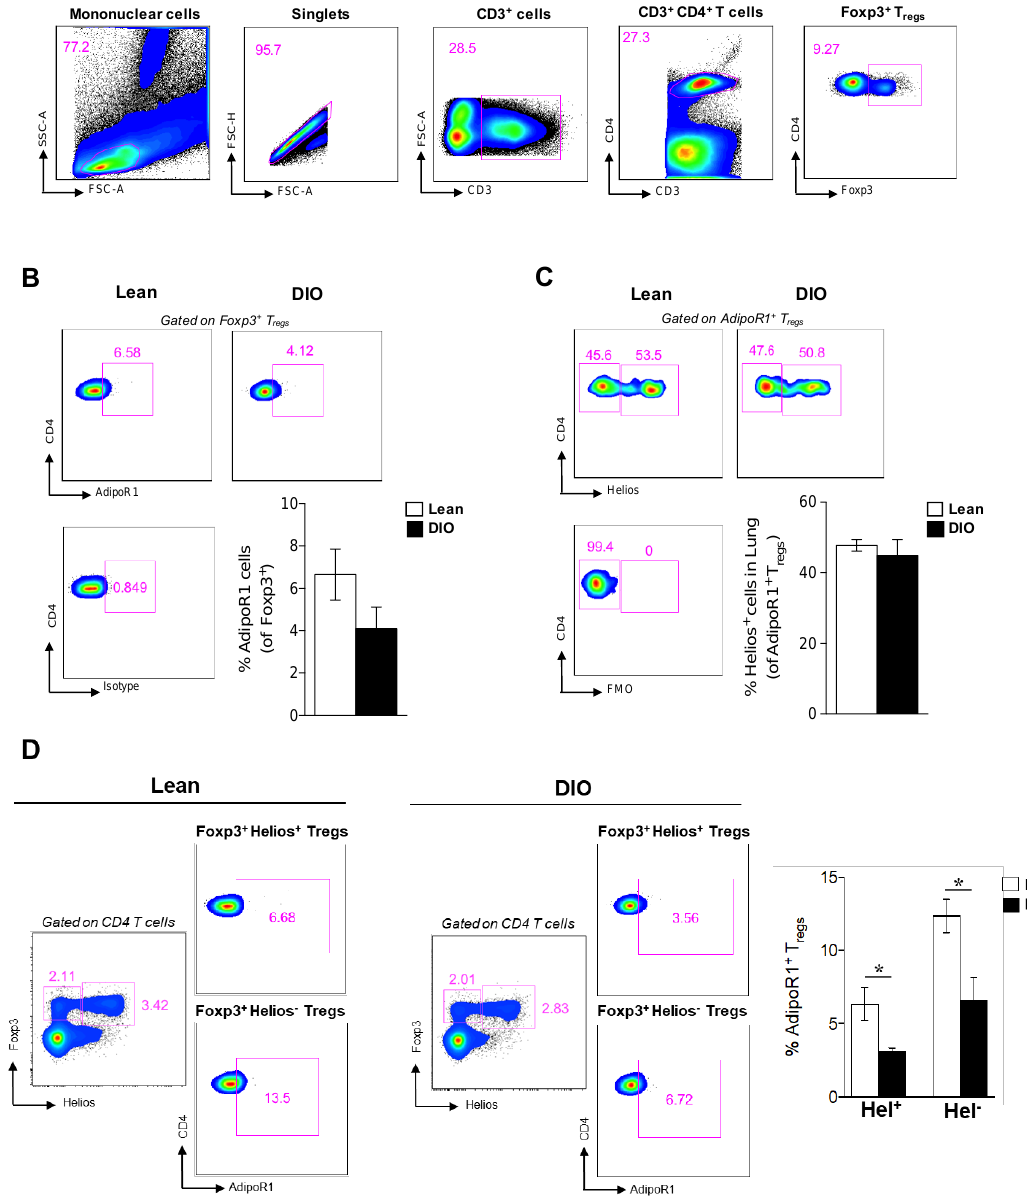
Figure 2. AdipoR1 + Foxp3 + Tregs were diminished in the lungs of DIO mice at 21 weeks of age. ( A ) The gating strategy of lung Tregs (CD3 + CD4 + Foxp3 + ). ( B ) Representative plots show the AdipoR1 expression in Foxp3 + Tregs and the frequency of AdipoR1-expressing Foxp3 + Tregs in the lungs of lean and obese mice. The AdipoR1 + population was gated within CD3 + CD4 + Foxp3 + cells. ( C ) Helios expression in lung AdipoR1 + Foxp3 + Tregs (CD3 + CD4 + Foxp3 + AdipoR1 + cells). ( D ) Helios and Foxp3 were used to discriminate subsets of Tregs in lungs of lean and obese mice. Representative plots show the Helios and Foxp3 expression within CD4 T cells and the AdipoR1 expression in Helios + and Helios - Foxp3 + Tregs in lean and obese mice. AdipoR1 cells were determined from CD3 + CD4 + Foxp3 + Helios + or CD3 + CD4 + Foxp3 + Helios - cells. Data are means ± SEM of n = 3 – 6 mice per group. Unpaired t test * p < 0.05. DIO, diet-induced obesity; AdipoR1, adiponectin receptor 1; and Tregs, regulatory T